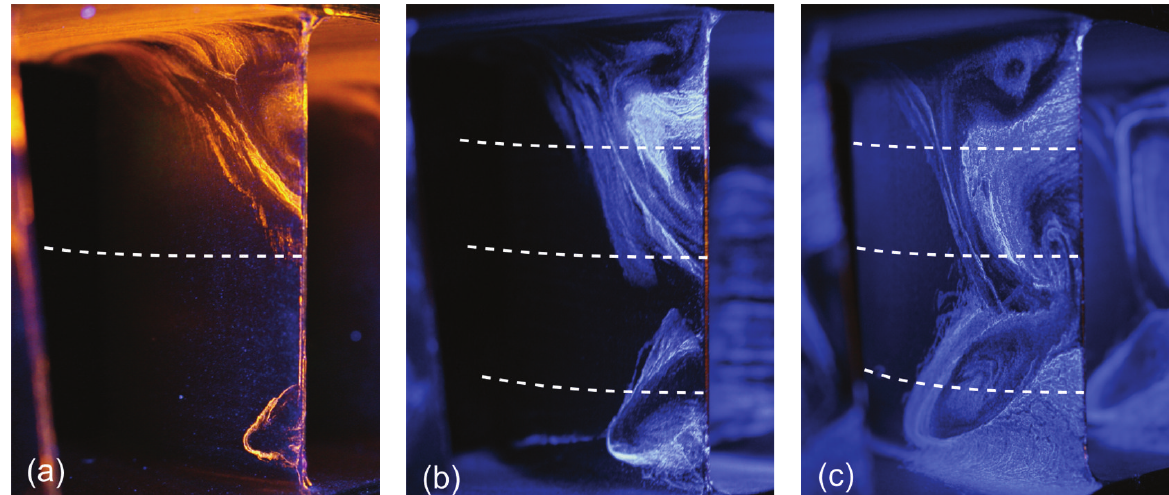
Figure 10: Flow visualization of vane boundary layer separations along Stator 2 suction surface at three loading conditions: (a) low loading, (b) peak efficiency, and (c) 17%SM high